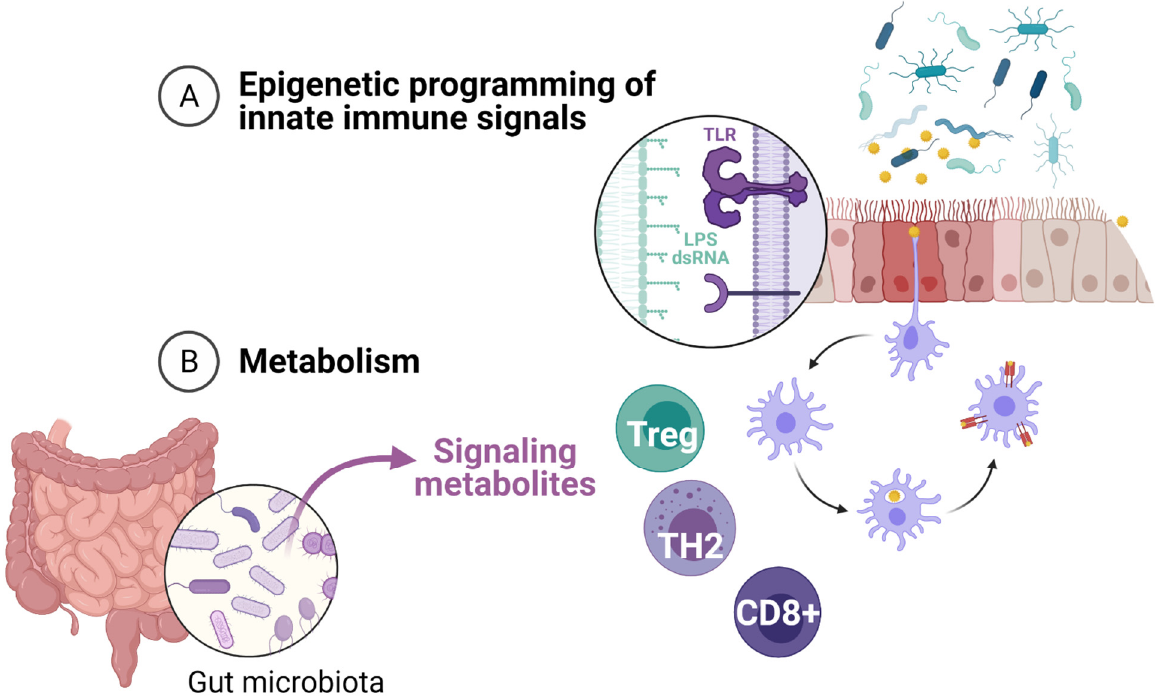
Figure 1. Early innate immune training of the respiratory system. Mechanisms of innate immune training include ( A ) direct environmental programming of the airway epithelium and innate immune cells in the respiratory mucosa, and ( B ) systemic effects driven by gut microbiota signaling metabolites.